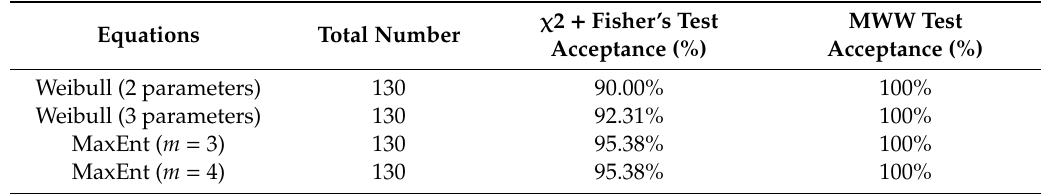
Table 4. Acceptance statistic of Weibull distribution and MaxEnt distribution of fitted results for 130 plots.